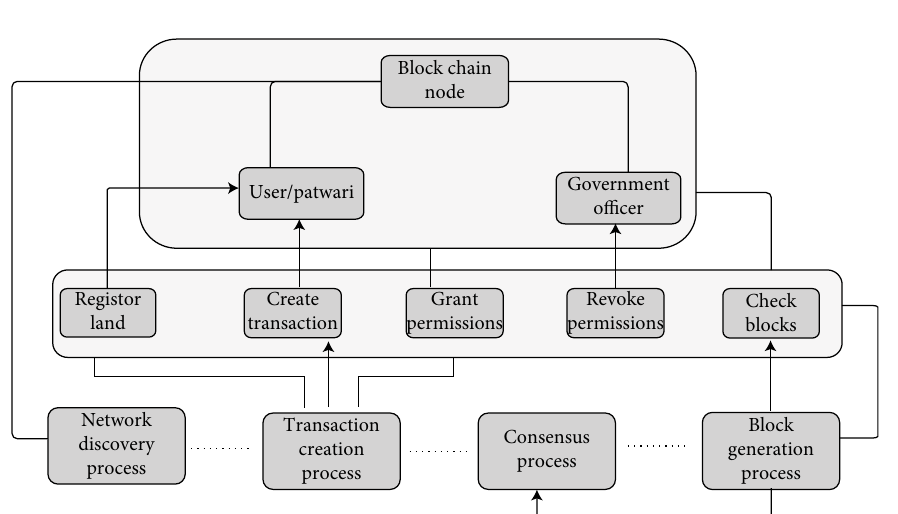
Figure 11: Data block model.